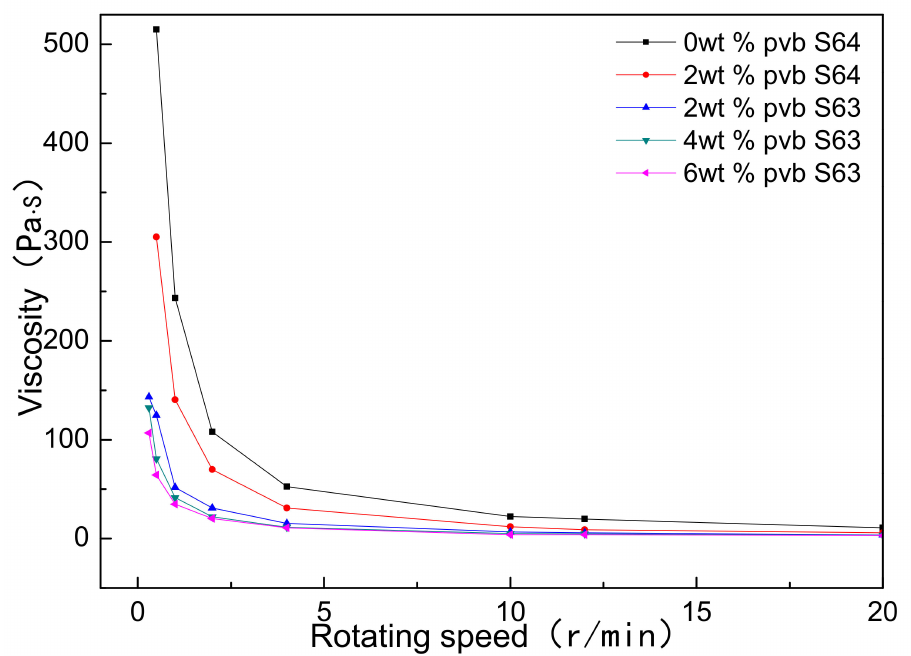
Figure 2. Viscosity changes of Al(OH) 3 /carbon/ethanol slurries with different PVB additions.